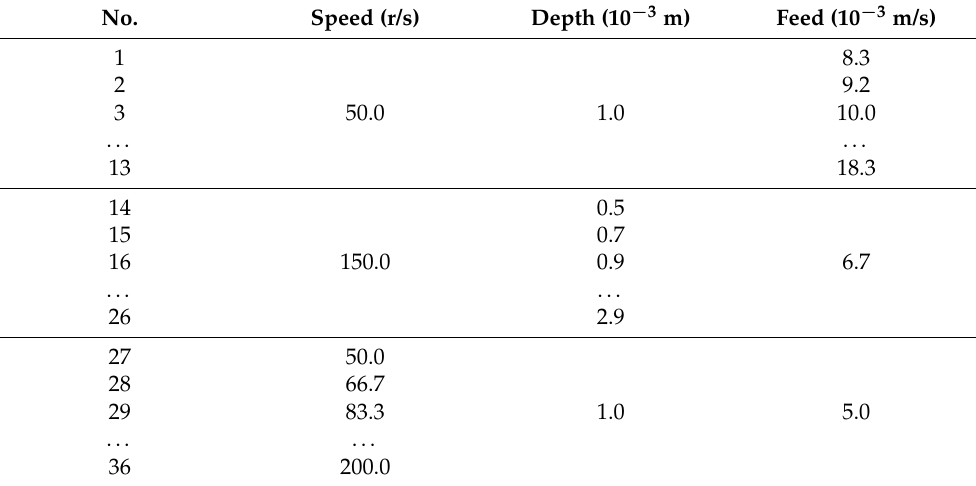
Table 2. 36 groups of machining parameters with various feed, cut depth and speed values.